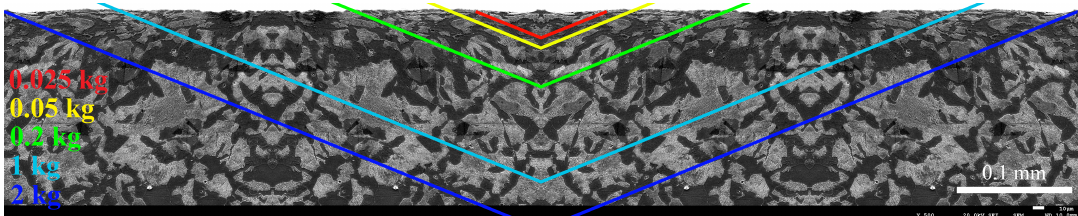
Figure 2. Schematic representation of the penetration achieved with the indentations with different loads on the tested steel, based on real experimental values.